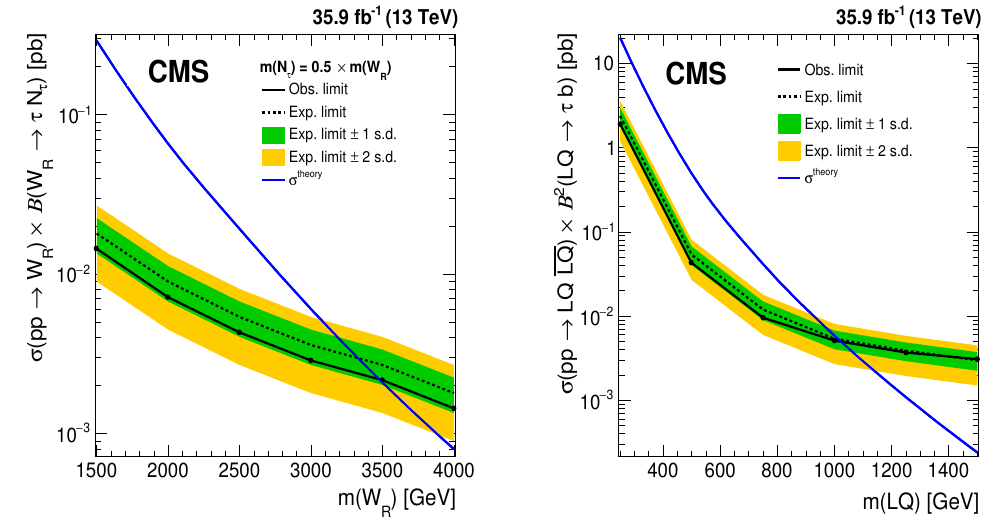
Figure 6 . Upper limits at 95% CL on the product of the cross section and the branching fraction for the production of W R (left) decaying to N and for a pair of leptoquarks each decaying to (cid:28) b (cid:28) (right), as functions of the produced particle mass. The observed limits are shown as solid black lines. Expected limits and their one- (two-) standard deviation limits are shown by dashed lines with green (yellow) bands. The theoretical cross sections are indicated by the solid blue lines.